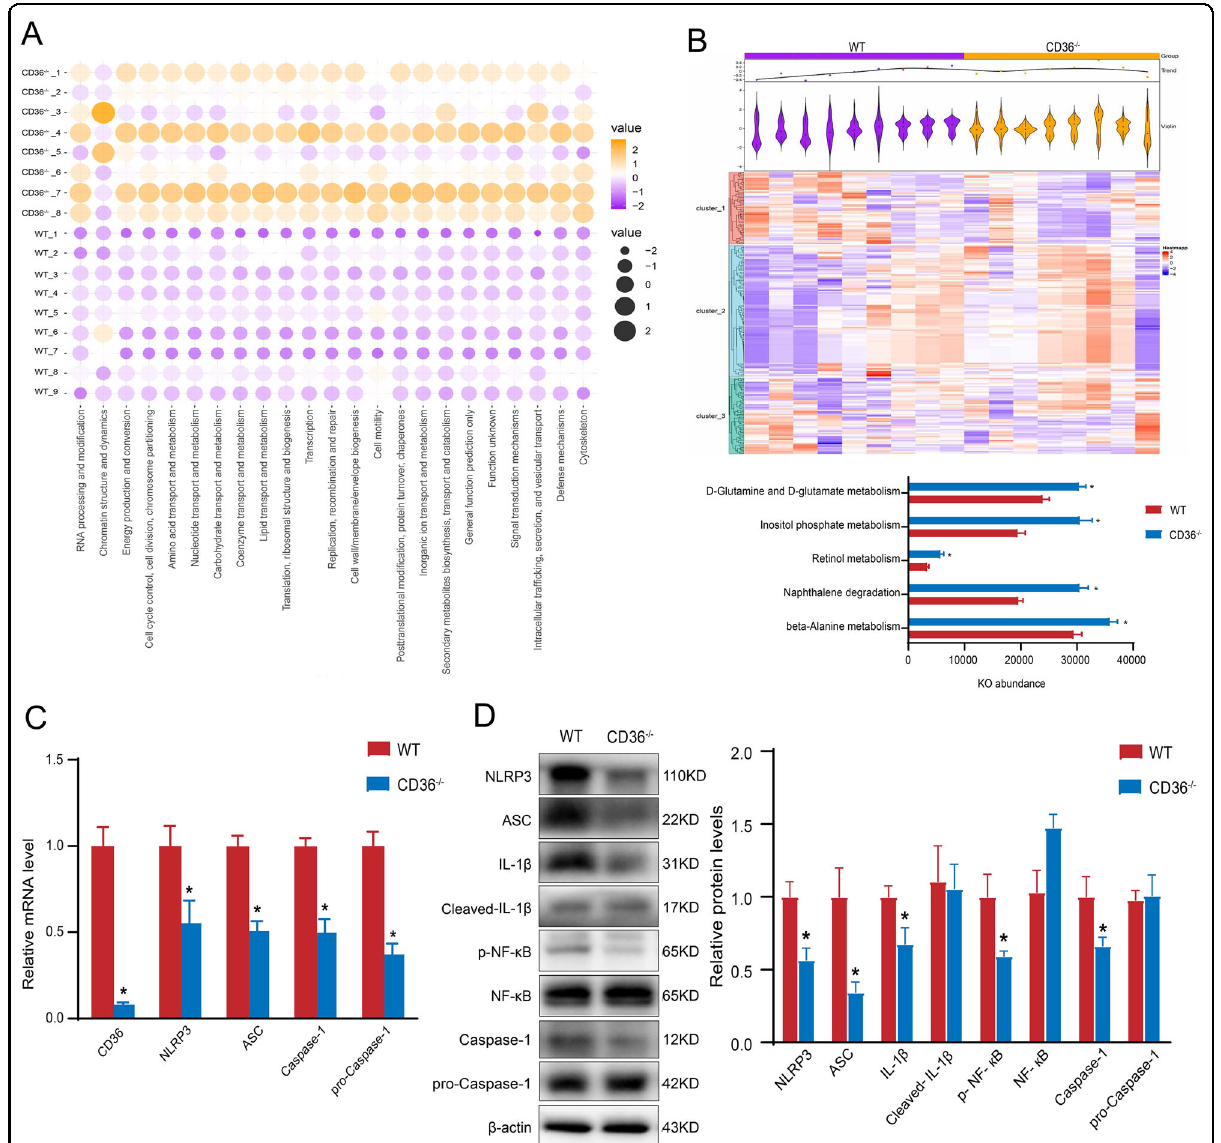
prediction analysis by COG functional classi fi cation. b KEGG pathway enrichment of gut microbiota between the two groups ( n = 8 – 9 mice/group, * P < 0.05). Genetic ablation of CD36 in mice alters the NLRP3/caspase-1 in fl ammatory pathway ( c , d ). c Hippocampal mRNA levels of NLRP3, ASC, pro- caspase-1 and caspase-1 in CD36 − / − mice ( n = 6 – 7 mice/group, P < 0.05). d Representative western blotting for hippocampal NLRP3, ASC, IL-1 β